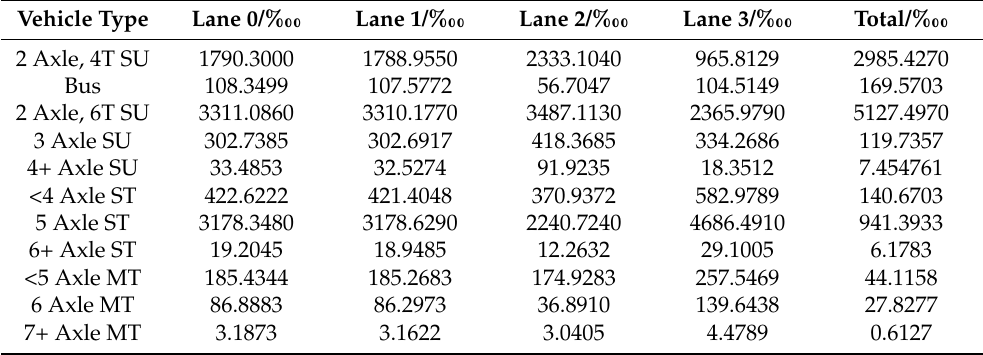
Table 1. Lane occupancy by vehicle type.